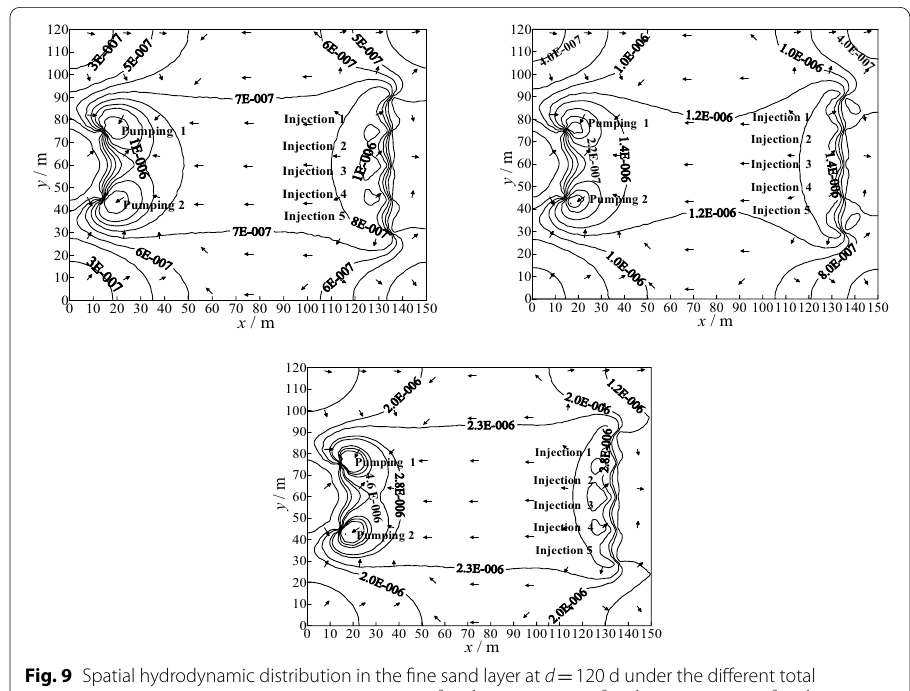
Fig. 9 Spatial hydrodynamic distribution in the fine sand layer at d pumping–injection flow volume ∑ G : a ∑ G